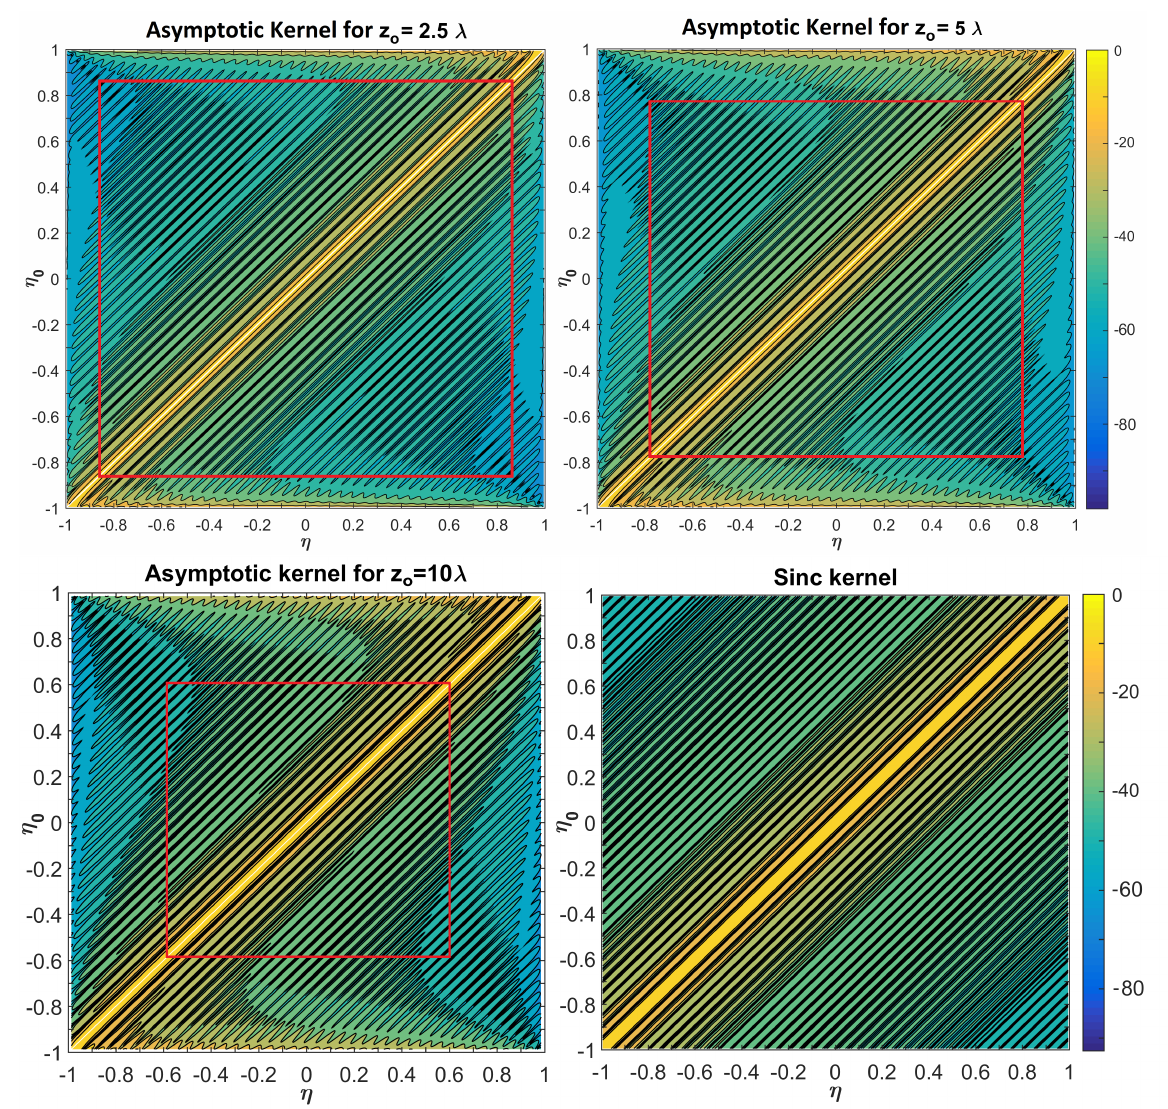
Figure 3. Amplitude of K ( η , η o ) provided by the asymptotic evaluation for z o = { 2.5 λ ,5 λ ,10 λ } , and amplitude of the sinc kernel. The diagrams are shown in dB, and they refer to a source with a = 10 λ ( η ( a ) = 0.78 )